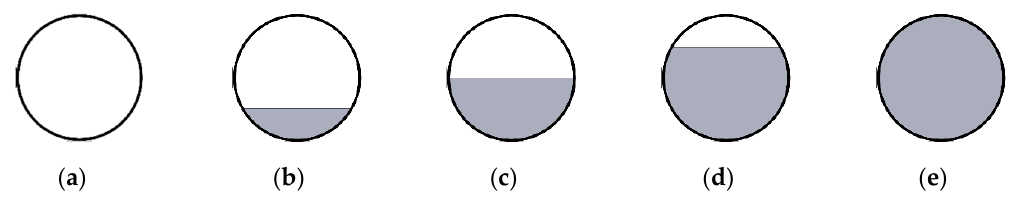
Figure 6. Five grouting levels. ( a ) Case G1; ( b ) Case G2; ( c ) Case G3; ( d ) Case G4; and ( e ) Case G5.